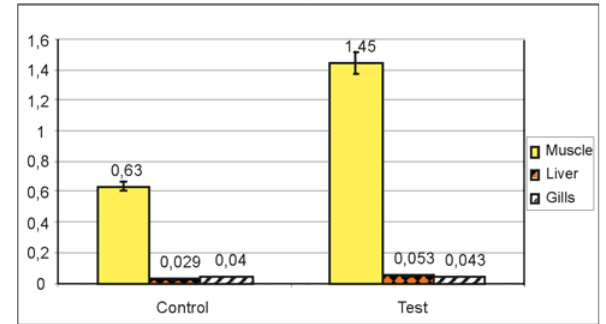
Fig. 9. Cadmium concentration (mg/kg) in tissues of rainbow trout